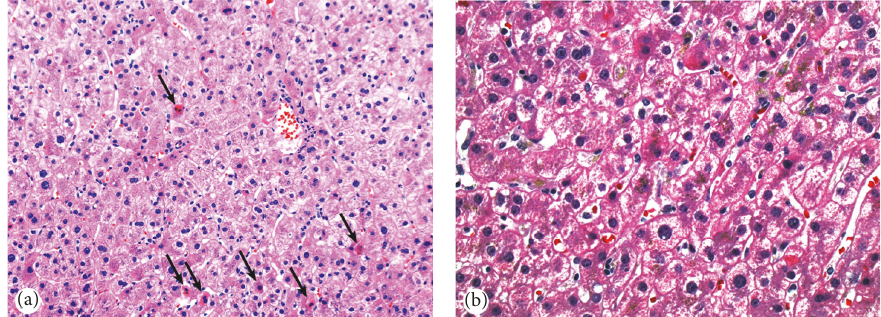
Figure 1: Liver biopsy. (a) Hematoxylin and eosin × 20: liver biopsy specimen showing lobular disarray with numerous apoptotic hepatocytes (arrows) and increased sinusoidal inflammatory cells. No steatosis or frank necrosis is present. (b) Hematoxylin and eosin × 40: liver biopsy specimen showing lobular disarray, prominent apoptotic hepatocytes, and biliary stasis, compatible with recent drug induced liver